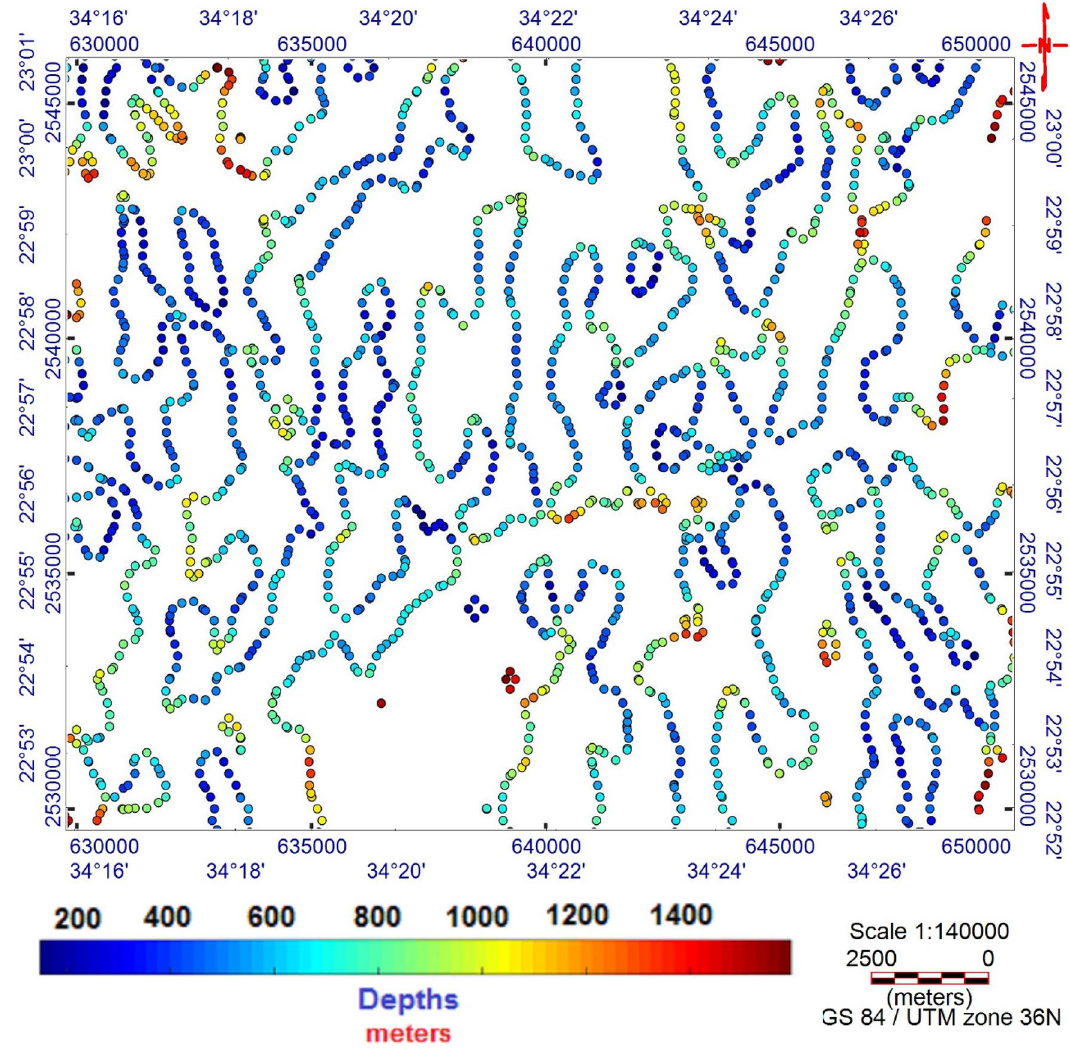
Figure 7. The Tilt Depth map of the magnetized ore bodies of Akab El-Negum